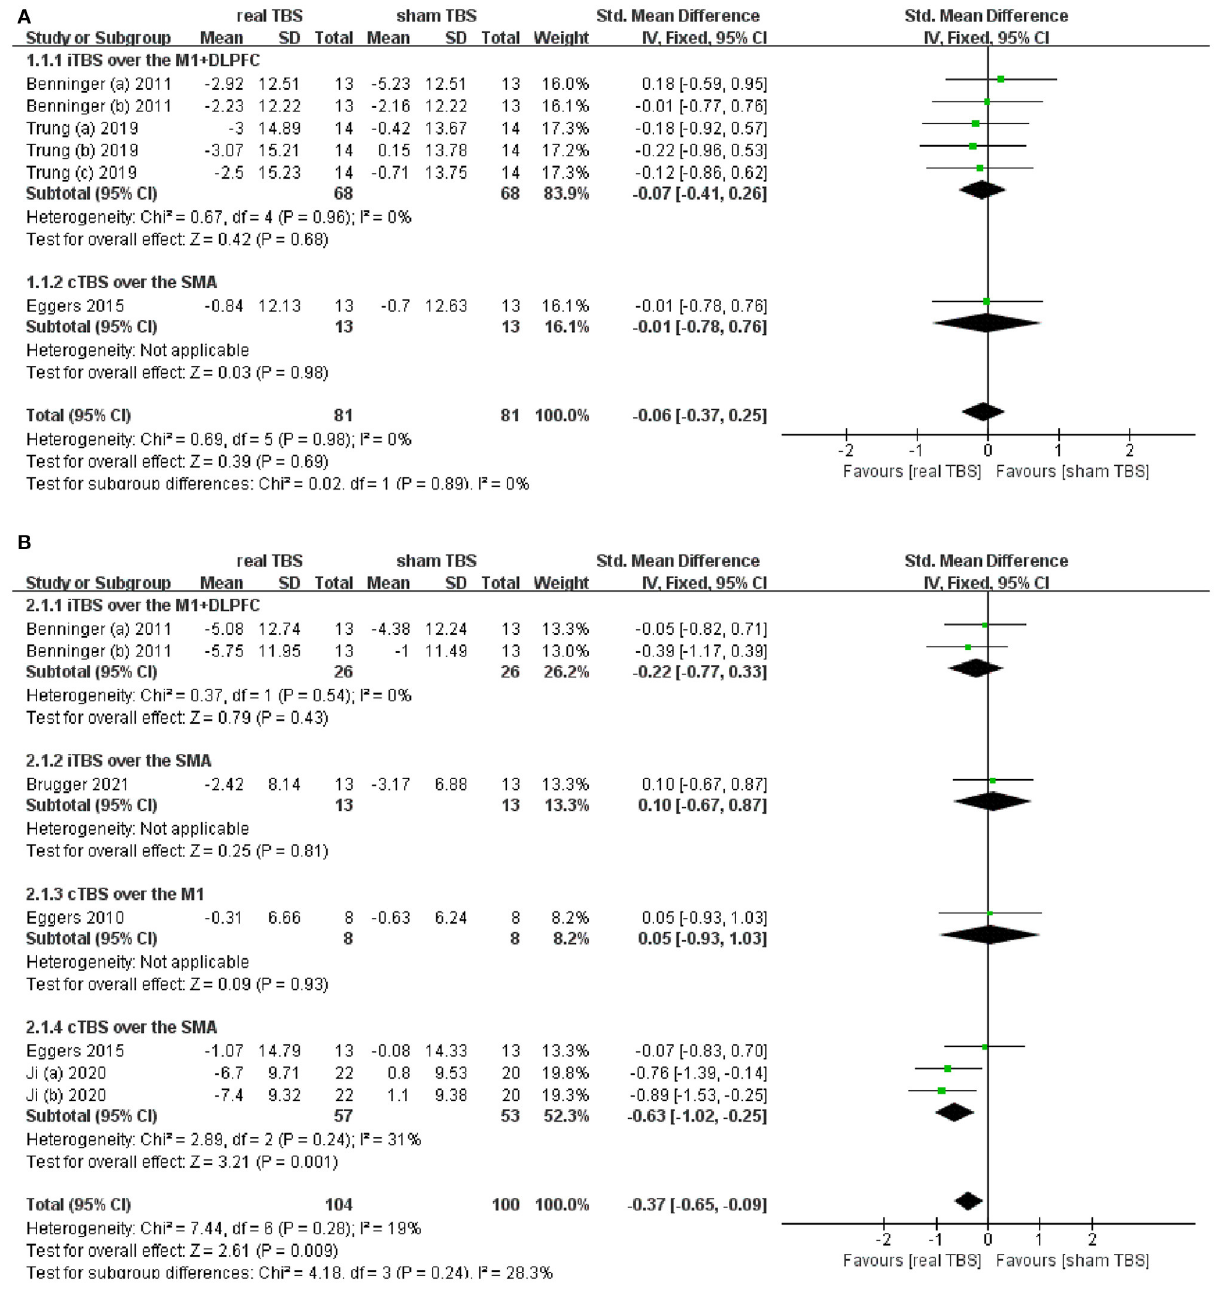
FIGURE 2 | (A) Forest plot and metaanalysis of UPDRS-III score between real TBS and sham TBS in the “on” medicine state: subgroup analysis based on iTBS/cTBS-brain targets. (B) Forest plot and metaanalysis of UPDRS-III score between real TBS and sham TBS in the “off” medicine state: subgroup analysis based on iTBS/cTBS-brain